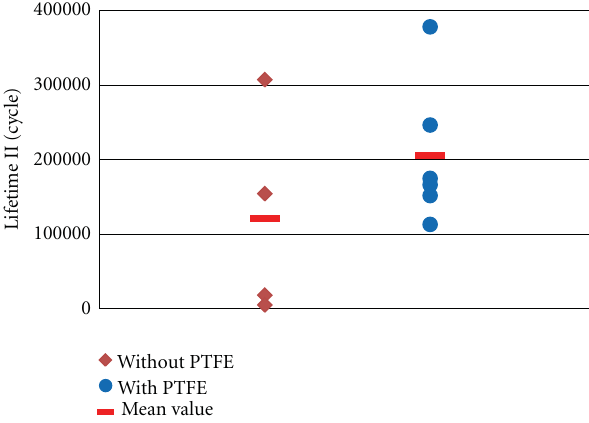
Figure 15: E ff ect of PTFE particles on